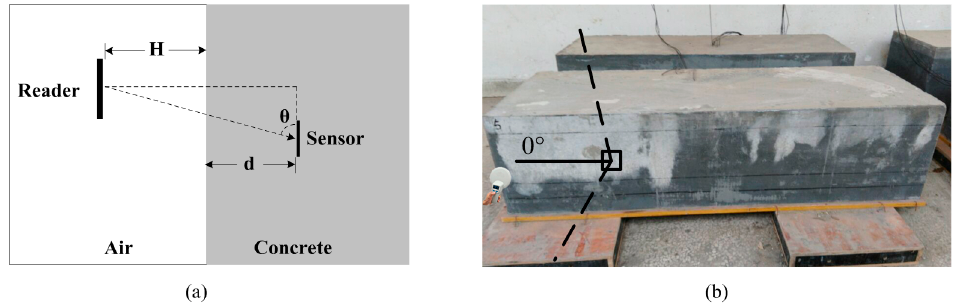
Figure 17. ( a ) Experimental scheme; ( b ) Test site.